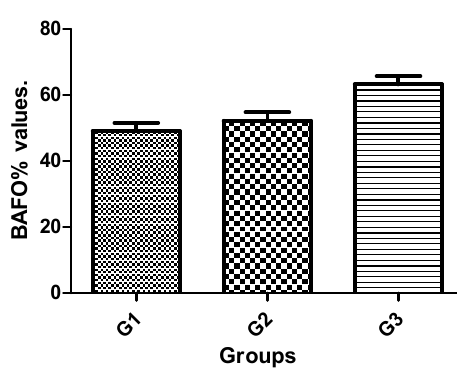
Figure 10. Bar graph of the BAFO% mean and standard deviation.